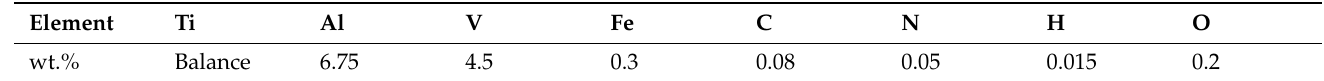
Table 1. TC4 titanium alloy base material composition.